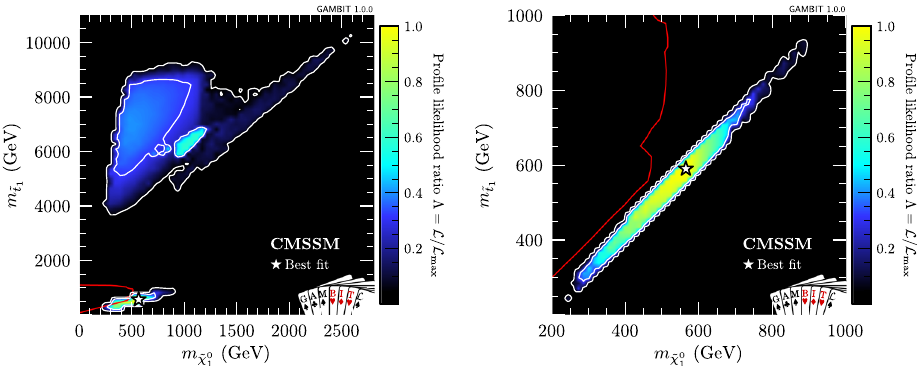
II simplified model limit for ˜ t 1 pair production, followed by decay to t 1 quarks andthelightestneutralino[319].Thislimitshouldbeinterpreted with caution (for details see main text)